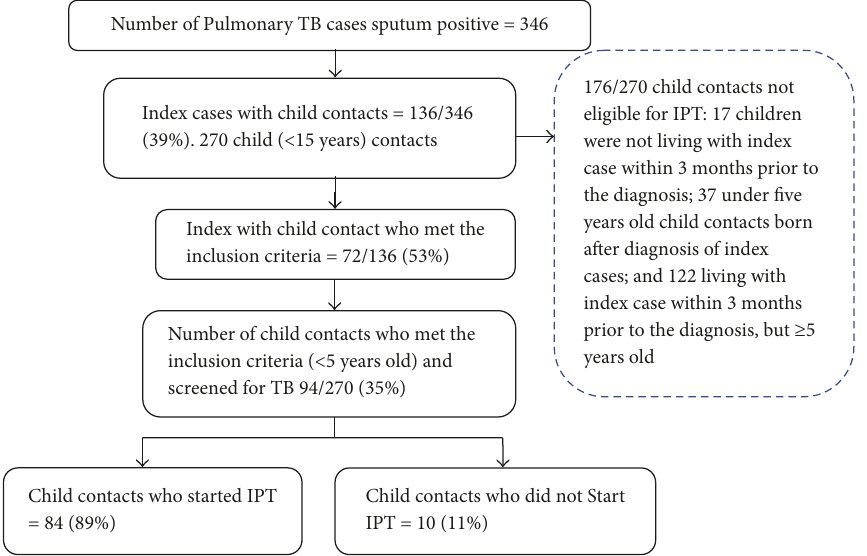
Figure 1: Flow of recruitment of child TB